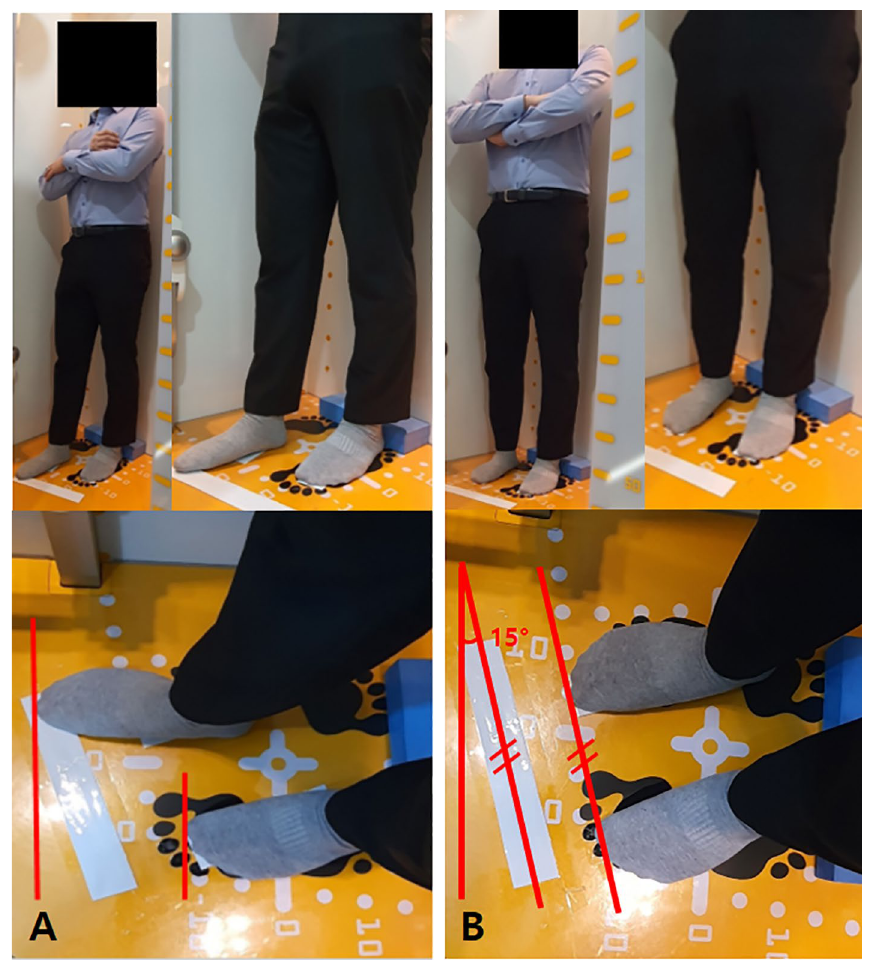
Figure 1. ( A ) Conventional standing posture for the EOS imaging system. ( B ) Modified rotated posture with even load distribution on both lower extremities. The red lines indicate the position and orientation of both